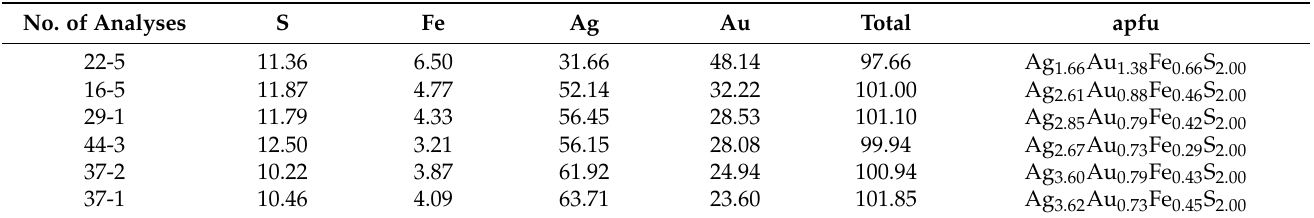
Figure 5. Paragenesis of uytenbogaardtite (Uyt), acanthite (Aca), and native gold (Au) in iron hydroxides: BSE and raster images display the distribution of the elements. Table 4. Chemical composition of uytenbogaardtite (in wt.%).